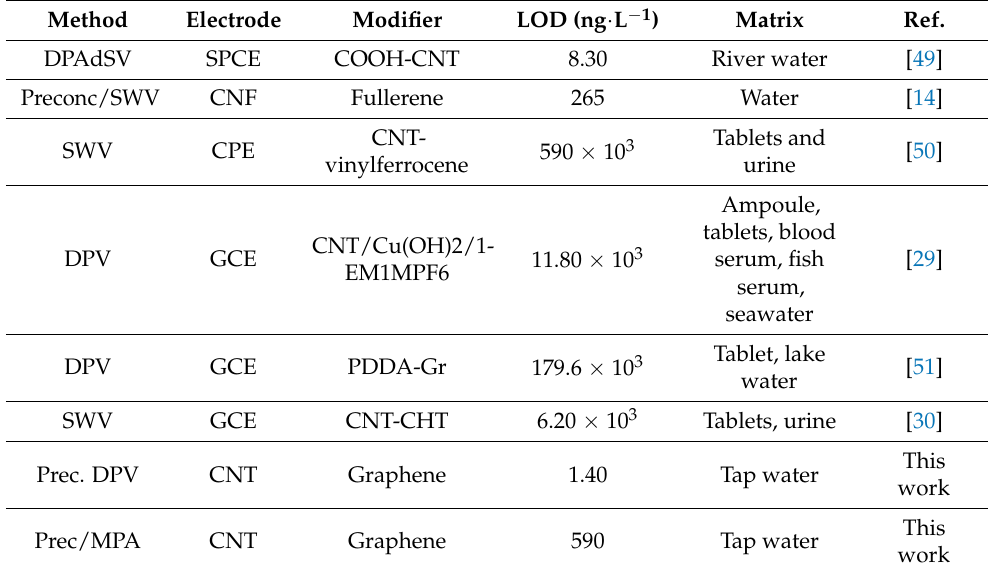
Table 6. Comparative performances for electrochemical sensing of diclofenac of GR-CNT paste electrode and carbon-based electrodes reported in the